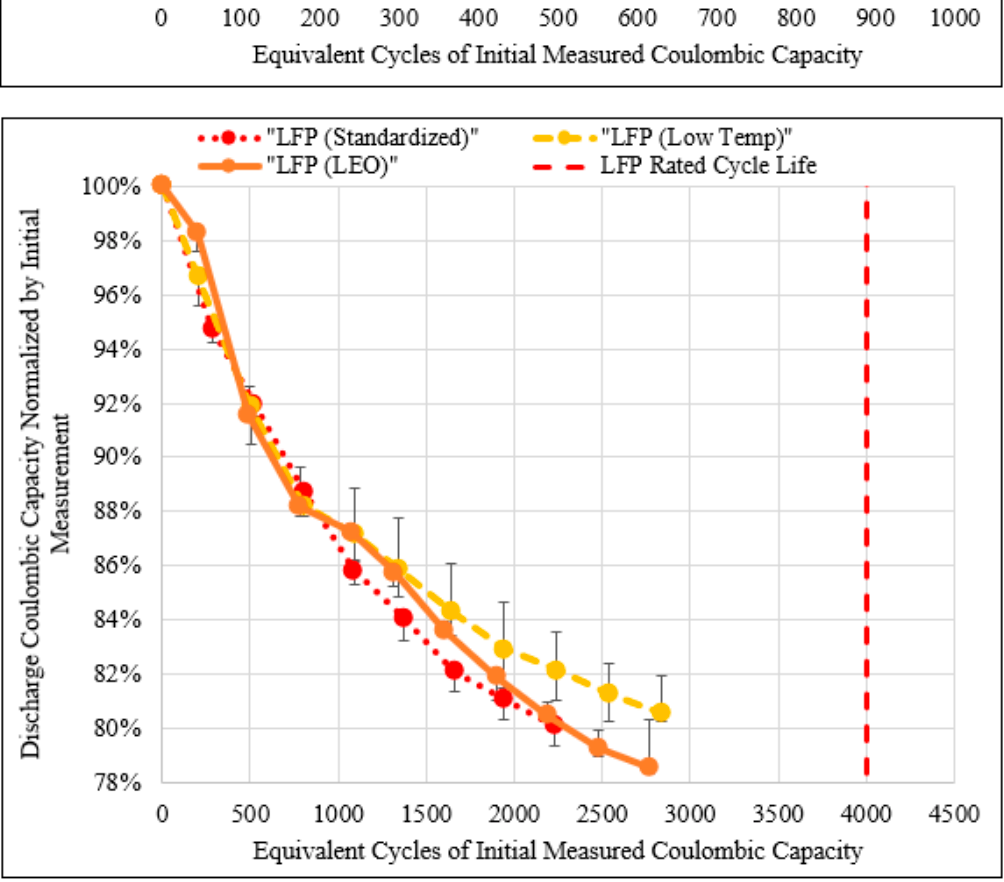
Figure 4. Normalized discharge energy capacity measured at reference cycles versus number of equivalent cycles for each cell type ( top : NCA, NMC; bottom : LFP) and LEO cycling condition. Manufacturer specification sheet 80% cycle life marked by dashed vertical lines for NCA (250 cycles), NMC (300 cycles) and LFP (4000 cycles).